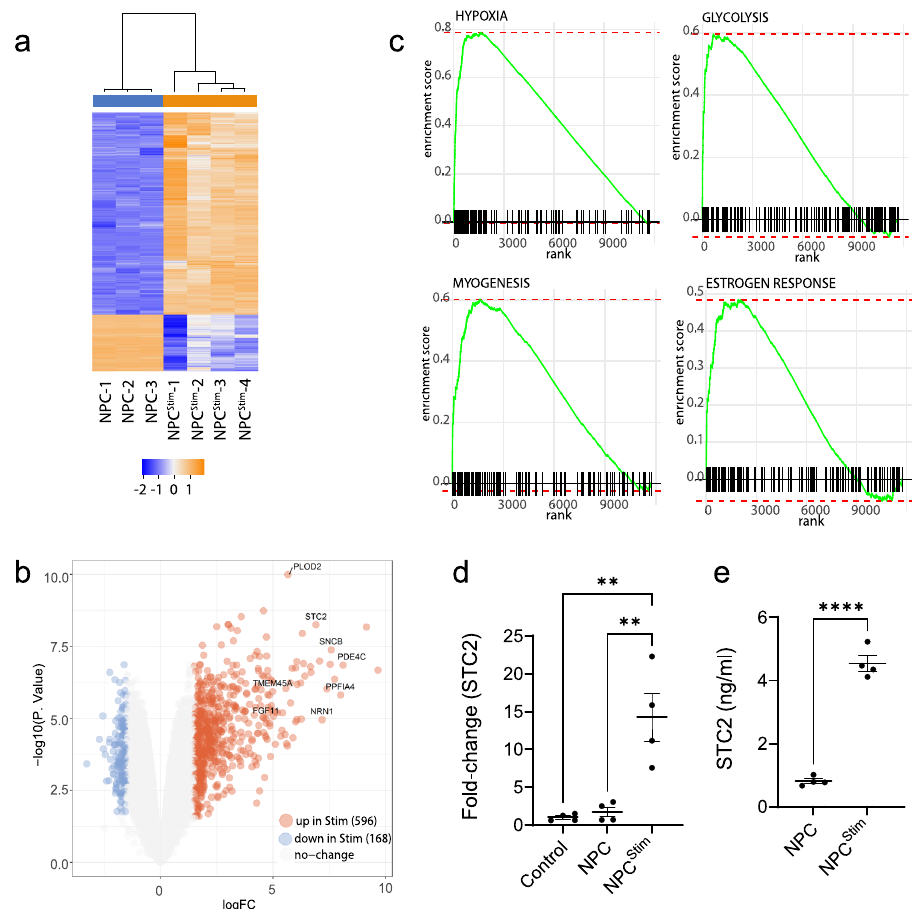
Fig. 3 Transcriptome changes between electrically stimulated and unstimulated NPCs. a Heatmap of transcriptome changes in NPCs from electrical stimulation (NPC – unstimulated, NPC Stim – electrically stimulated; blue-downregulated, orange-upregulated). b Volcano plot demonstrating changes in genes with electrical stimulation (blue-downregulated, orange-upregulated). c Top Gene set enrichment pathways with STC2 as the leading edge. d qRT- PCR analysis indicated that STC2 in NPCs was upregulated by electrical stimulation. e ELISA study indicated that the level of STC2 protein after electrical stimulation (NPC Stim ) is much higher than that in non-stimulated NPCs (NPC). d , e Analyzed using a one-way ANOVA, followed by Tukey ’ s HSD post-hoc test with ** P < 0.01, **** P < 0.0001, data shown as mean ± SEM, n =